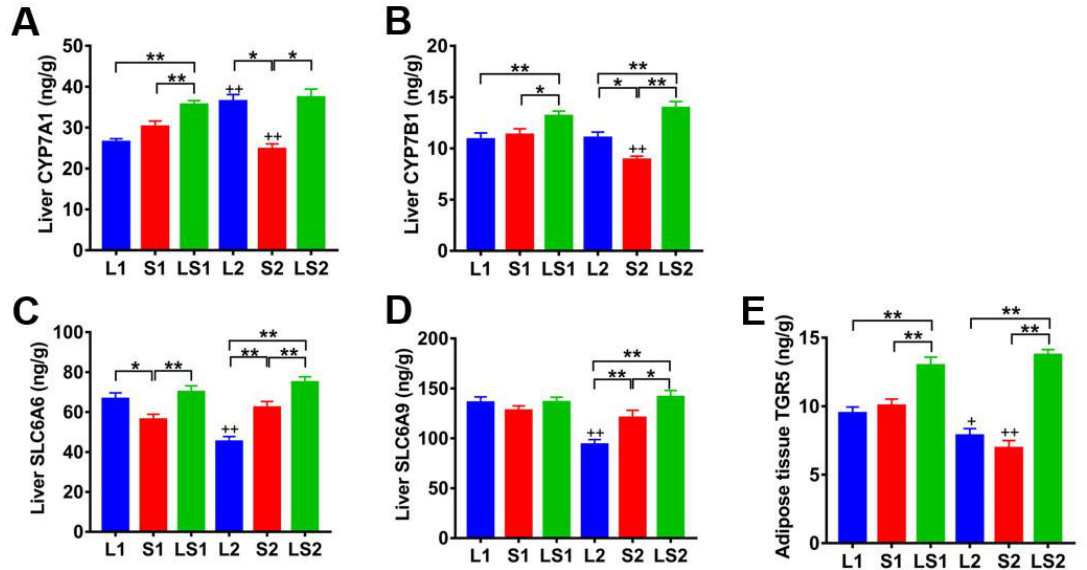
Figure 10. Impacts of various oil/fat diets on proteins related to bile aids. ( A ) Expression of CYP7A1 in liver; ( B ) expression of CYP7B1 in liver; ( C ) levels of SLC6A6 in liver; ( D ) levels of SLC6A9 in liver; ( E ) levels of TGR5 in adipose tissue. “*” represents significant differences at p < 0.05; “**” represents significant differences at p < 0.01; “+” represents significant differences at p < 0.05 relative to the same oil type with different energy level; “++” represents significant differences at p < 0.01 relative to the same oil type with different energy level.